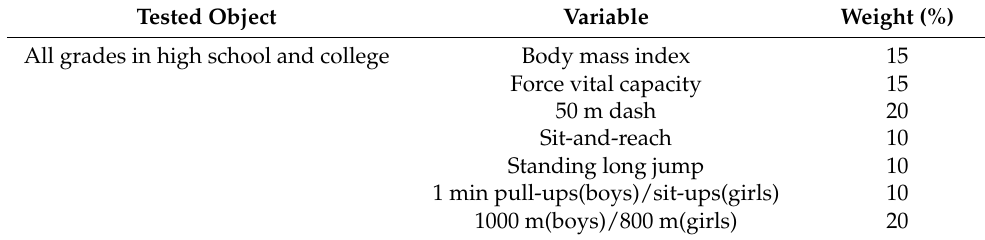
Table 1. Cont. Tested Object Variable Weight (%) All grades in high school and college Body mass index 15 Force vital capacity 15 50 m dash 20 Sit-and-reach 10 Standing long jump